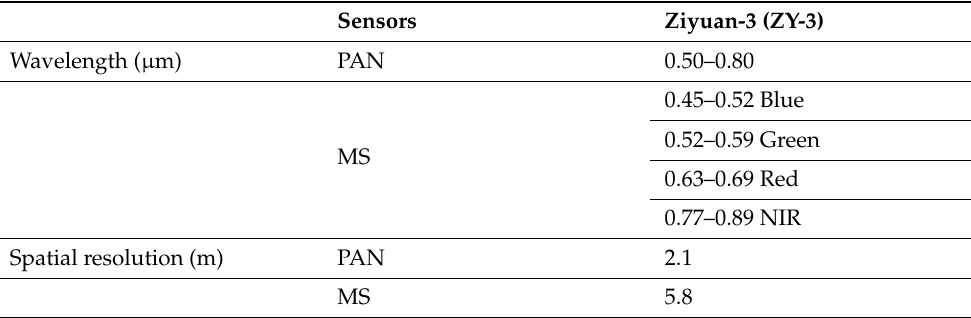
Table 2. Characteristics of the Ziyuan-3 (ZY-3)